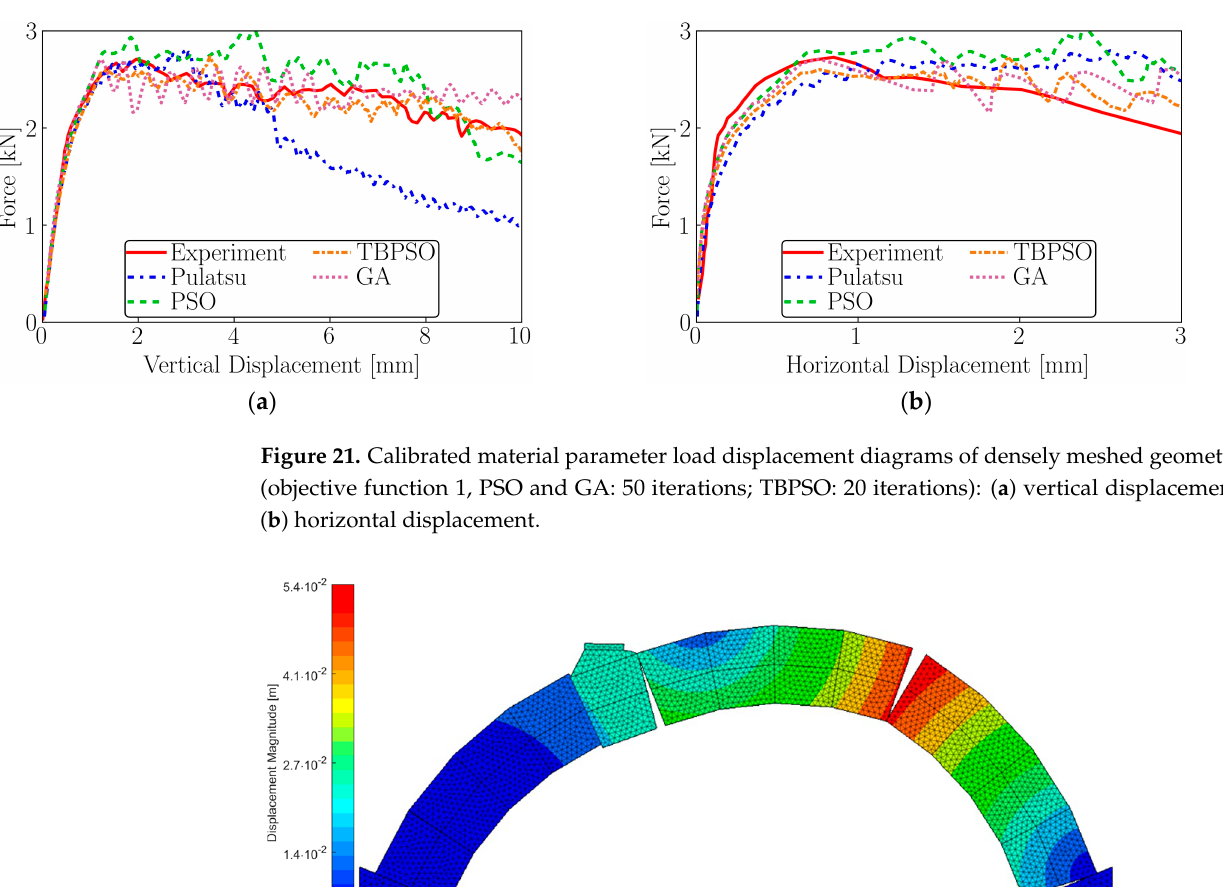
Figure 23. Position of calibrated material parameters of densely meshed geometry (objective func- tion 2, PSO and GA: 50 iterations; TBPSO: 20 iterations). Table 4 . Five best solution sets for objective function 2 of densely meshed geometry.